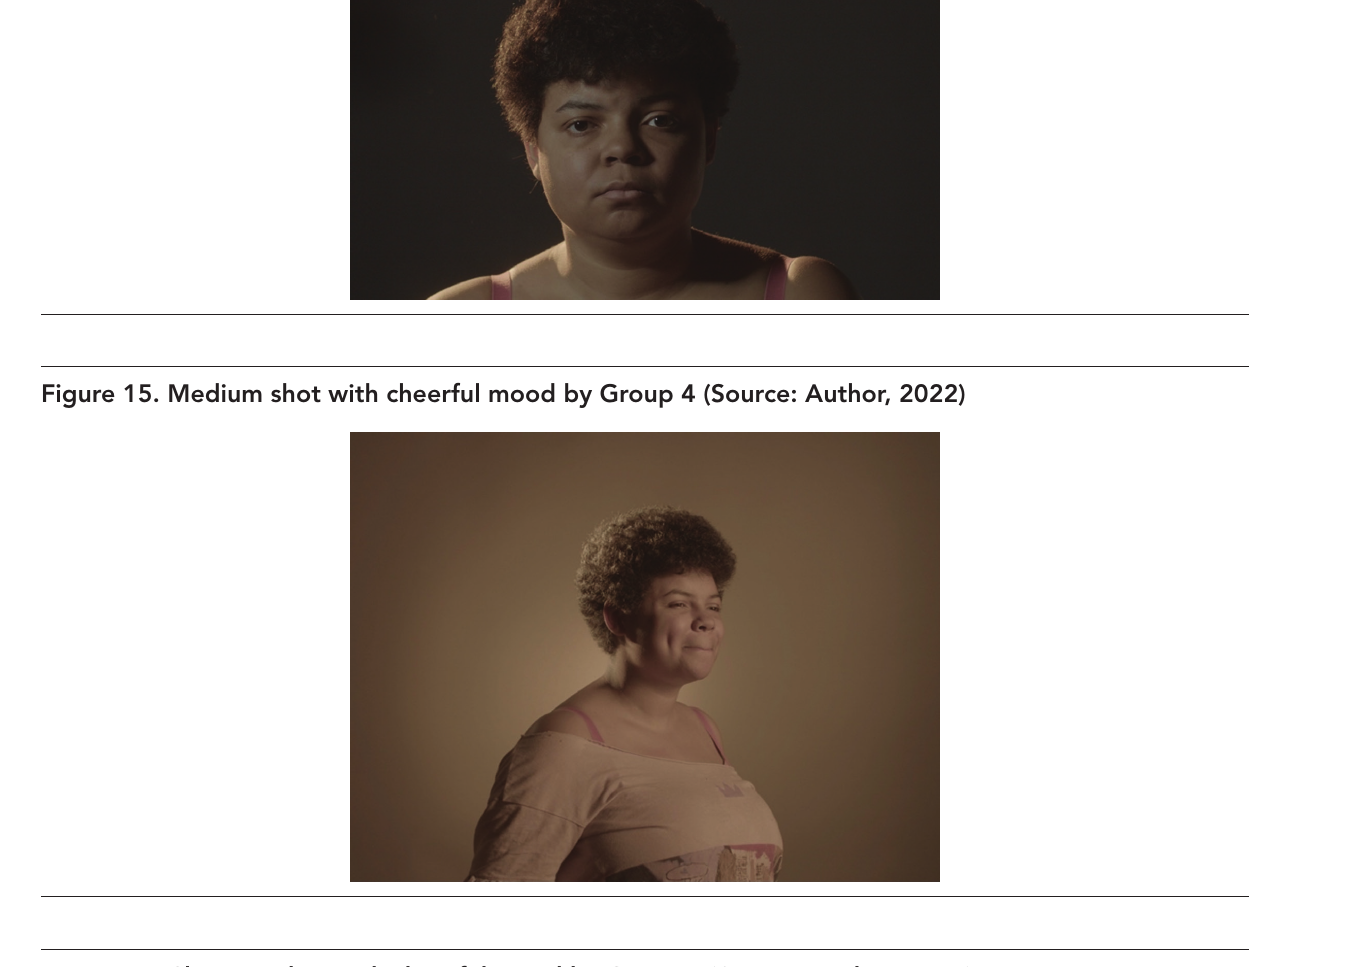
Figure 16. Close-up shot with cheerful mood by Group 4 (Source: Author,